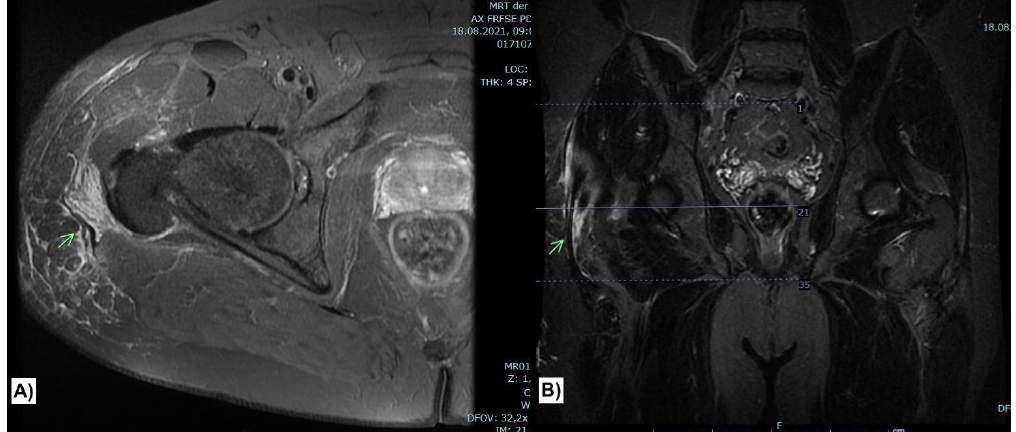
Figure 2. Axial FRFSE PD sequence ( A ) showing collection of hematoma medial to the iliotibial band with disruption of the superficial insertion of the gluteus maximus muscle at the iliotibial band and intermuscular septum (Arrow). The injury is again demonstrated in coronal STIR sequence ( B